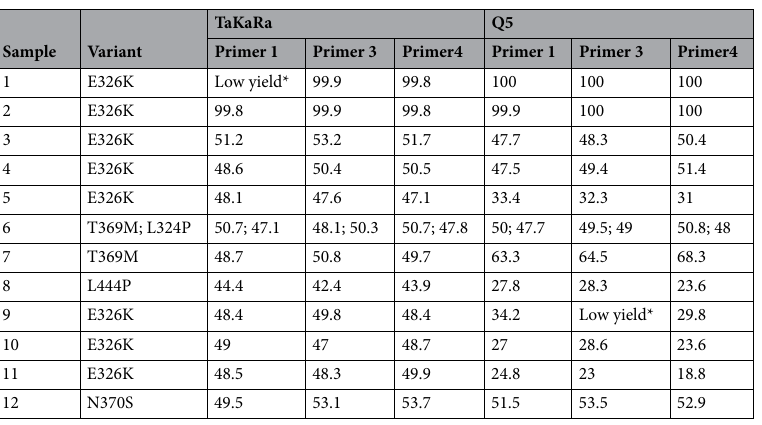
Table 2. Variant frequencies of GBA-PD samples based on three different primer sets unique for the functional GBA1 gene and two different polymerase enzymes. See Table 3 for HGVS nomenclature. *Two samples had a relatively low yield after PCR and could not reliably be